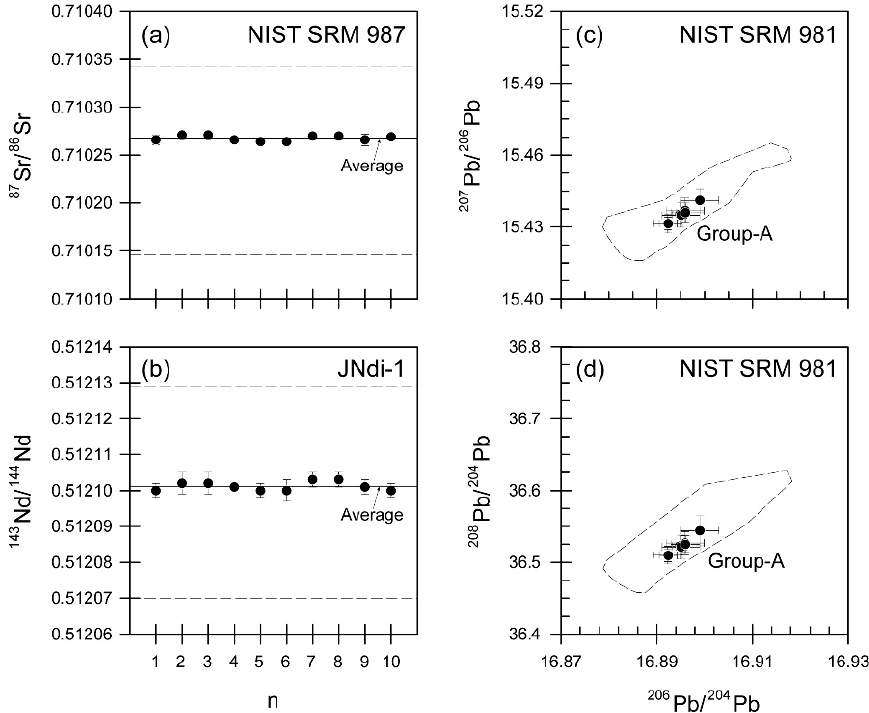
Figure 2. Replicate measurements of NIST SRM 987 for the Sr isotope ( a ) and JNdi-1 for Nd isotope ( b ), with the average (solid line) and the range (dashed lines) of the literature data from the GeoReM database (http://georem.mpch-mainz.gwdg.de/, accessed 1 October 2021). Plots of 207 Pb/ 204 Pb vs. 206 Pb/ 204 Pb ratios ( c ) and 208 Pb/ 204 Pb vs. 206 Pb/ 204 Pb ratios ( d ) showing the results obtained for NIST SRM 981 in a previous study [42] and this study. The dashed areas represent the range of Pb isotopic compositions of Group-A, obtained from [47].